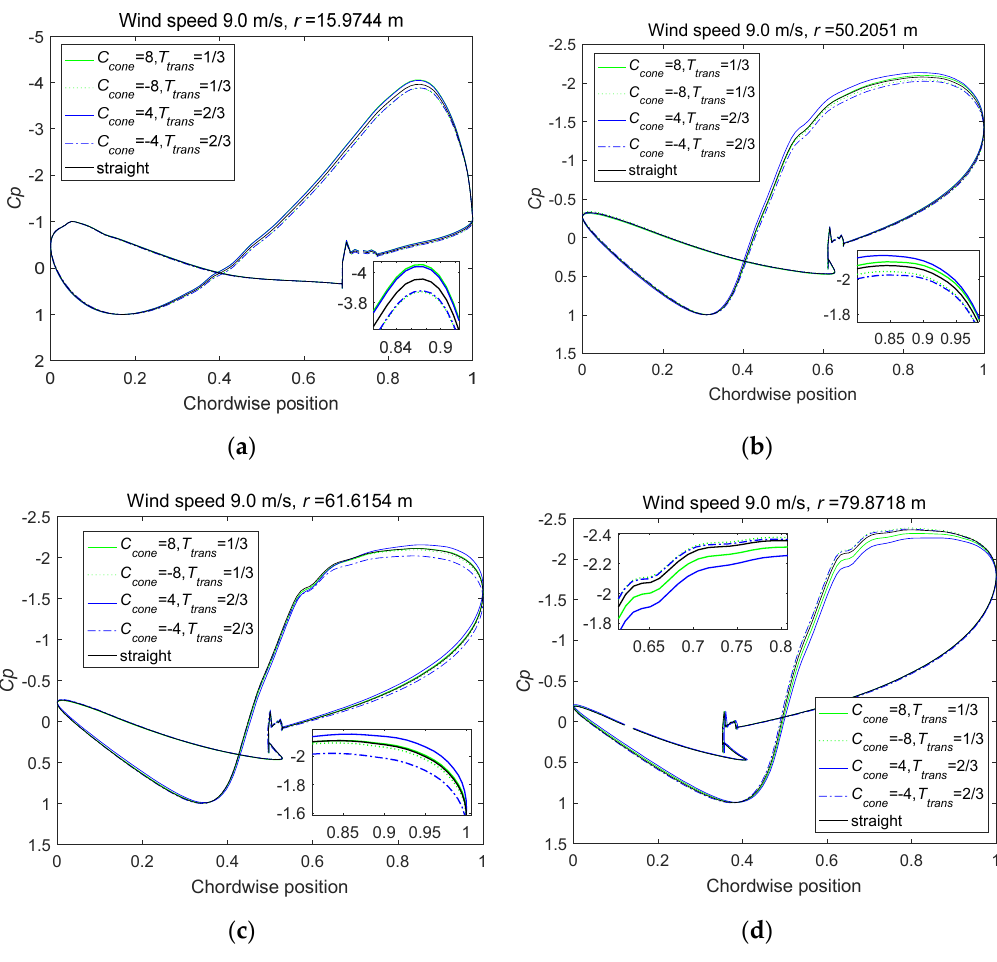
Figure 13. The pressure coefficient distributions at four radial positions (horizontal axis is normalized by the maximum thickness): ( a ) r = 15.9744 m, ( b ) r = 50.2051 m, ( c ) r = 61.6154 m, ( d ) r = 79.8718 m.